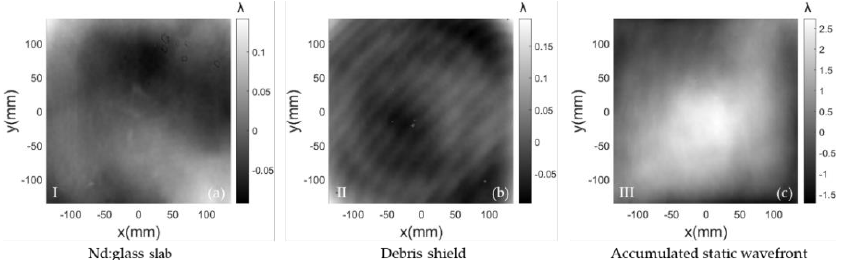
Figure 2. Typical wavefronts. ( a – c ) represent the measured wavefront of Nd:glass slab, debris shield, and an accumulated wavefront by superposing the wavefronts of all the elements according to the SG-II UP facility layout, respectively .